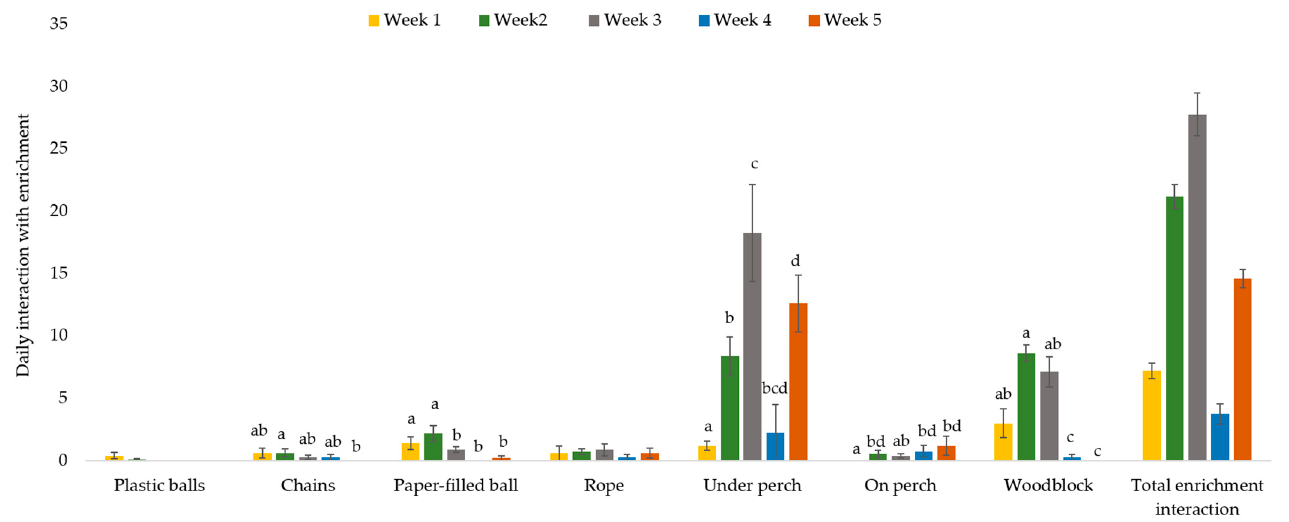
Figure 4. Average daily counts of interactions with environmental enrichments observed during hourly scan samples between 7:00–20:00 for birds provided with physical items (P birds only). Differing subscript (a, b, c, d) indicates significant difference of time spent interacting with a specific environmental enrichment over time/age ( p < 0.05).